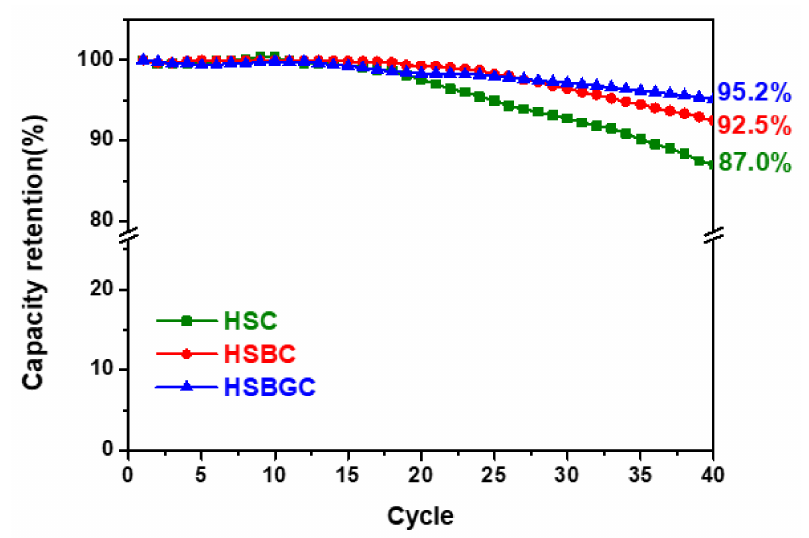
Figure 7. Capacity retention of HSC, HSBC, and